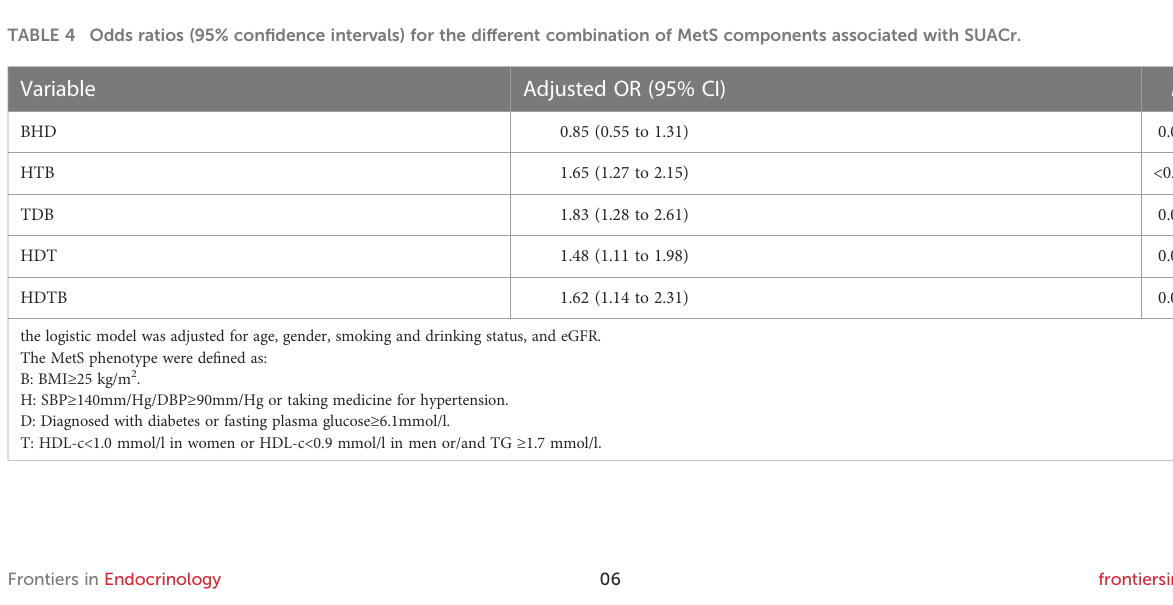
TABLE 4 Odds ratios (95% con fi dence intervals) for the different combination of MetS components associated with SUACr. Variable